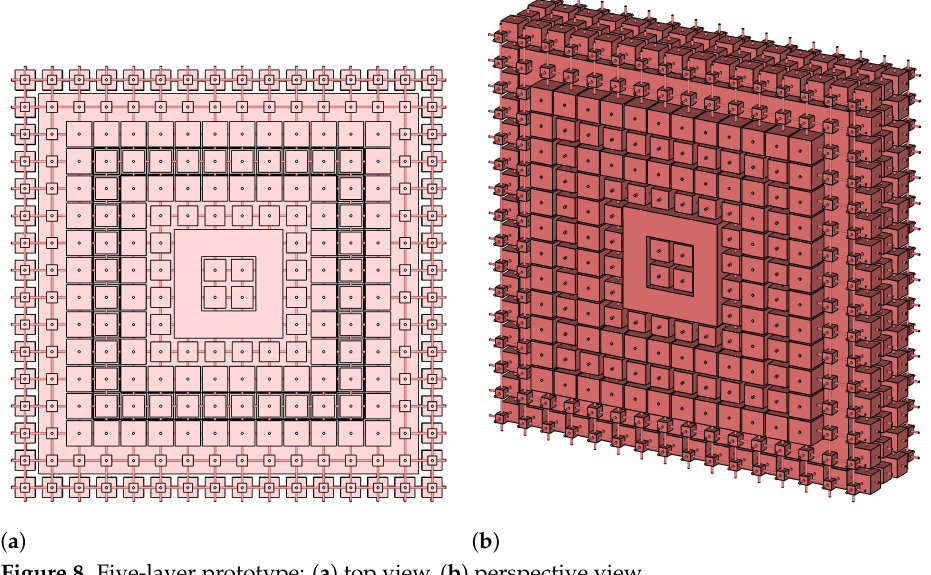
Figure 8. Five-layer prototype: ( a ) top view, ( b ) perspective view. In the next step, we have designed the CRS with a phase increment of 40 ◦ from the left of the aperture toward the right side. In each column of the phase distribution, the phase values will be the same, and it will be incremented as we move towards the next column. These phase values in degrees are highlighted in Figure 9. The minimum phase value of 0 ◦ and the maximum phase value of 320 ◦ are thus maintained. The 0 ◦ phase is kept in the fourth column starting from the left side and this 0 ◦ phase column is shifted right for each column, i.e., fifth, sixth, etc., to the sixteenth column and again shifting back to the first column, which is performed so as to obtain minimum side lobe level for the broadside condition. The increasing phase gradient is maintained from the bottom towards the upper side, which is along the E-plane.